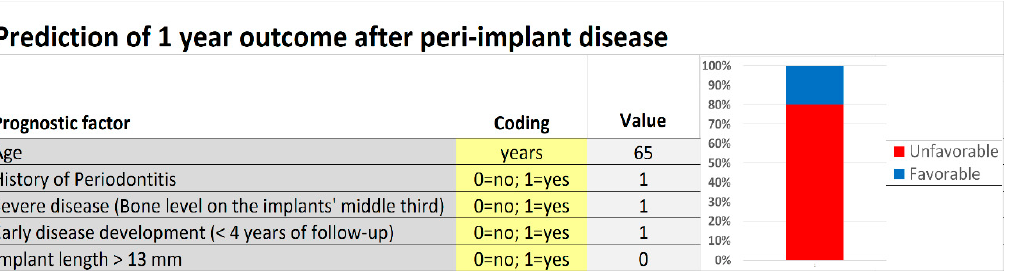
Figure 3. Screenshot illustrating the calculation of probability for the association between the risk